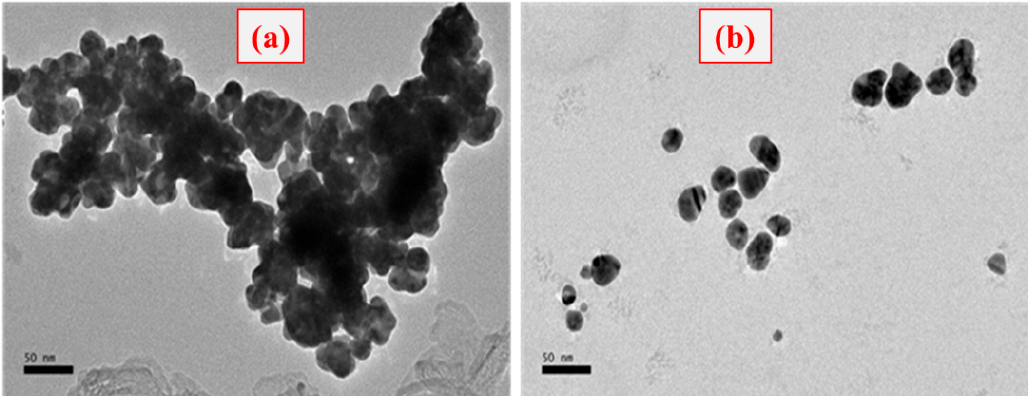
Figure 5. TEM images of GNPs morphology and state of aggregation of GNPs grown according to the reaction, ( a ) in the presence of CFP-10 and ( b ) in the absence of CFP-10.